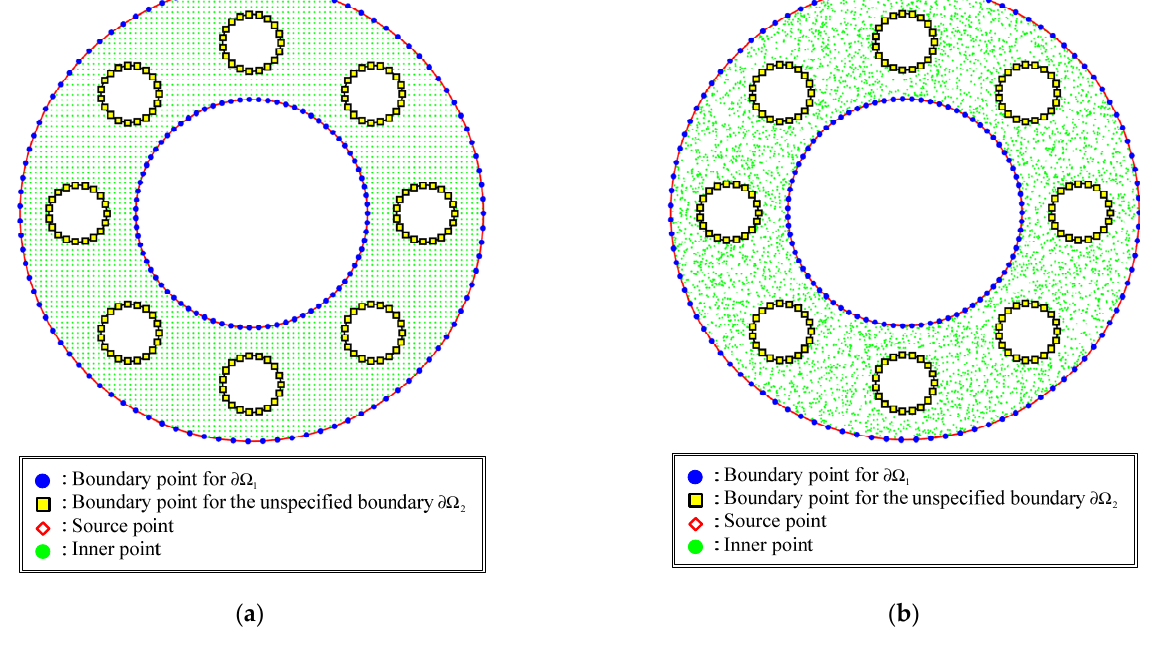
Figure 10. Layouts of the ( a ) uniformly distributed inner points and ( b ) randomly distributed inner points.